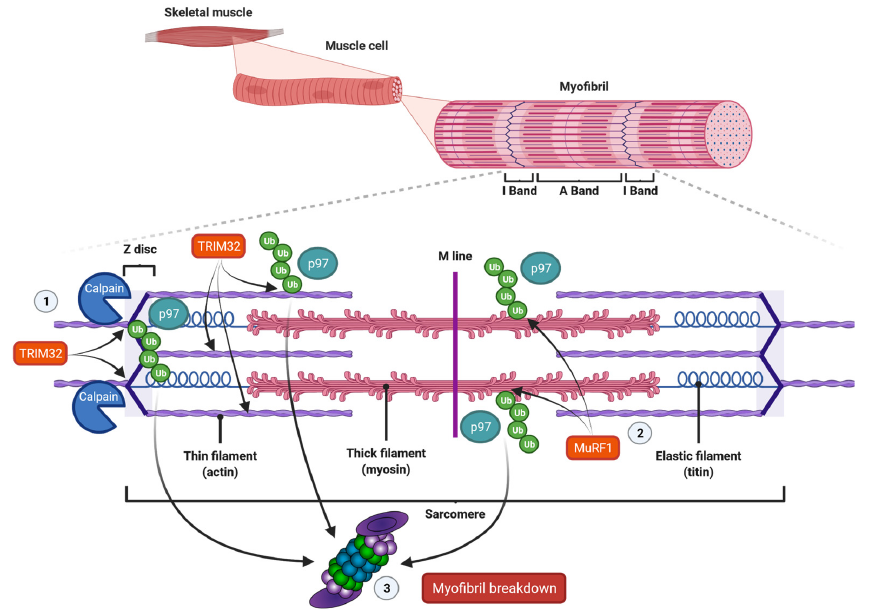
Figure 2. The loss of myofibrils is a highly ordered process. In a first step, calpains cleave desmin intermediate filaments (IF) to increase the accessibility for following breakdown. The E3 ubiquitin ligase TRIM32 acts on desmin IF and destabilizes the Z-disc (1). Besides that, TRIM32 is also responsible for ubiquitination of thin filaments. Next, the E3 ubiquitin ligase MuRF1 catalyzes the disassembly of thick filaments (2). Finally, the AAA ATPase p97/VCP releases ubiquitinated myofibrillar proteins to the cytosol where they are degraded by proteasomes (3). Created with https://bioren- der.com/.